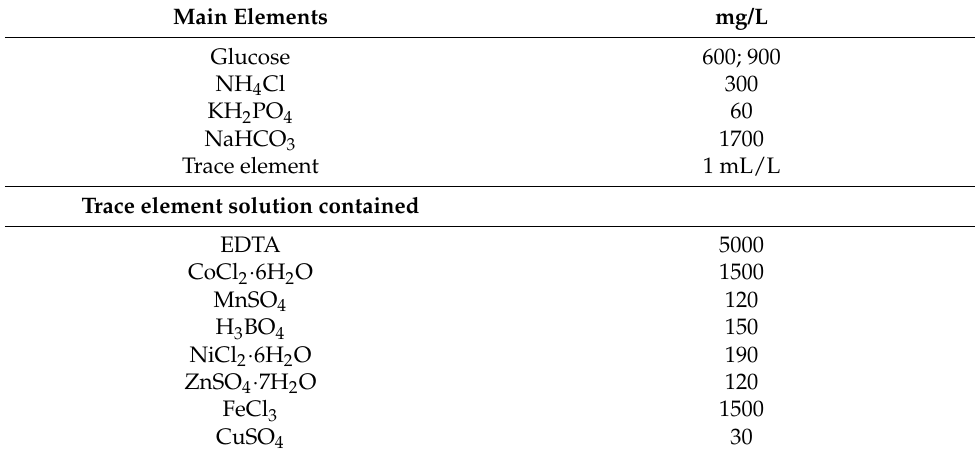
Table 1. Composition and trace element of synthetic wastewater.